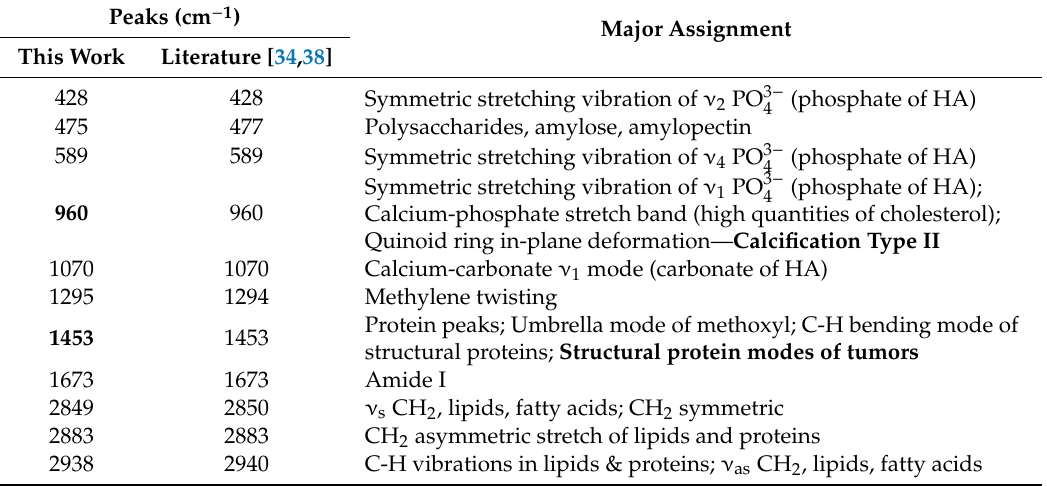
Figure 5. Raman spectra of mineralized areas of bone metaplasia of the mixed carcinoma (sample #3) and, on the right side, the corresponding microscopic image (50 × , Raman spectrometer system). In the inset is the microscopic image (2.5 × ) of a section of sample #3 where mineralized areas are stained black by means of the Von Kossa-Van Gieson modified method. Table 7. Peak position and assignment of mineralized areas of bone metaplasia of the mixed carcinoma (sample